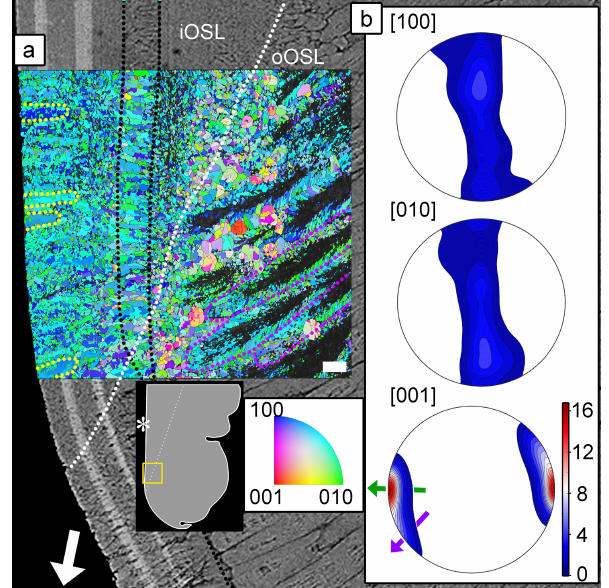
Figure 5. Orientation map for aragonite (a) of a pulsed Sr-labelled shell (specimen ID: K2-11) overlain on the BSE image of the same area. The dotted white line indicates the boundary between the crossed-acicular iOSL and prismatic oOSL shell layer portions. The organic growth check in the oOSL that continues as a prismatic layer in the iOSL is highlighted with dotted black lines. Blue, green, and red colours depict the crystallographic a [100], b [010], and c [001] axes of aragonite, respectively. Twinned grain boundaries are presented in red. The map is colour-coded to show the crys- tallographic orientation normal to the image plane. Predominantly green and blue colours in the map indicate that the a [100] and b [010] axes are randomly aligned mainly normal to the image plane. First-order prisms in the oOSL (some outlined in purple) have un- indexed cores, and feathery arranged second-order prisms are visi- ble at their rims. Individual lamellae of the iOSL form co-oriented stacks up to 17µm in size (circled in yellow). Pole figures (b) (lower hemisphere, equal area projection) show a strong clustering of the [001] axes for both layers. The local growth direction of the iOSL (green arrow), perpendicular to the light-grey Sr-labelled layers in the underlying BSE image, differs by about 90 ◦ from the general growth direction (white arrow in a ). The local growth direction of the oOSL (purple arrow) has a smaller angle with the general shell growth direction. The crystallographic a and b axes are randomly distributed in a plane normal to the local growth direction (i.e. par- allel to the growth lines of the iOSL). Maximum density values of pole figures are colour-coded according to scale with the [001] axes achieving 16.8 times uniform. A schematic of the shell tip shows the location of the orientation map and the BSE image. Asterisk marks the inner shell surface. Scale bar is